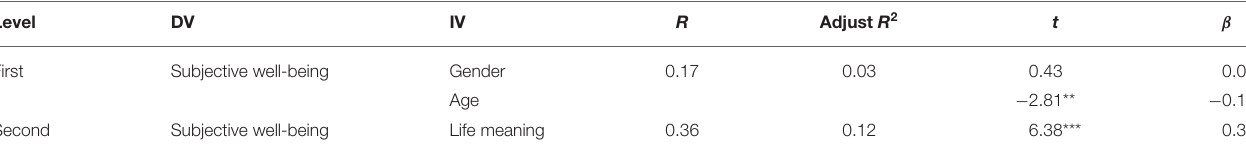
TABLE 2 | Hierarchical regression analysis of life meaning and subjective well-being.